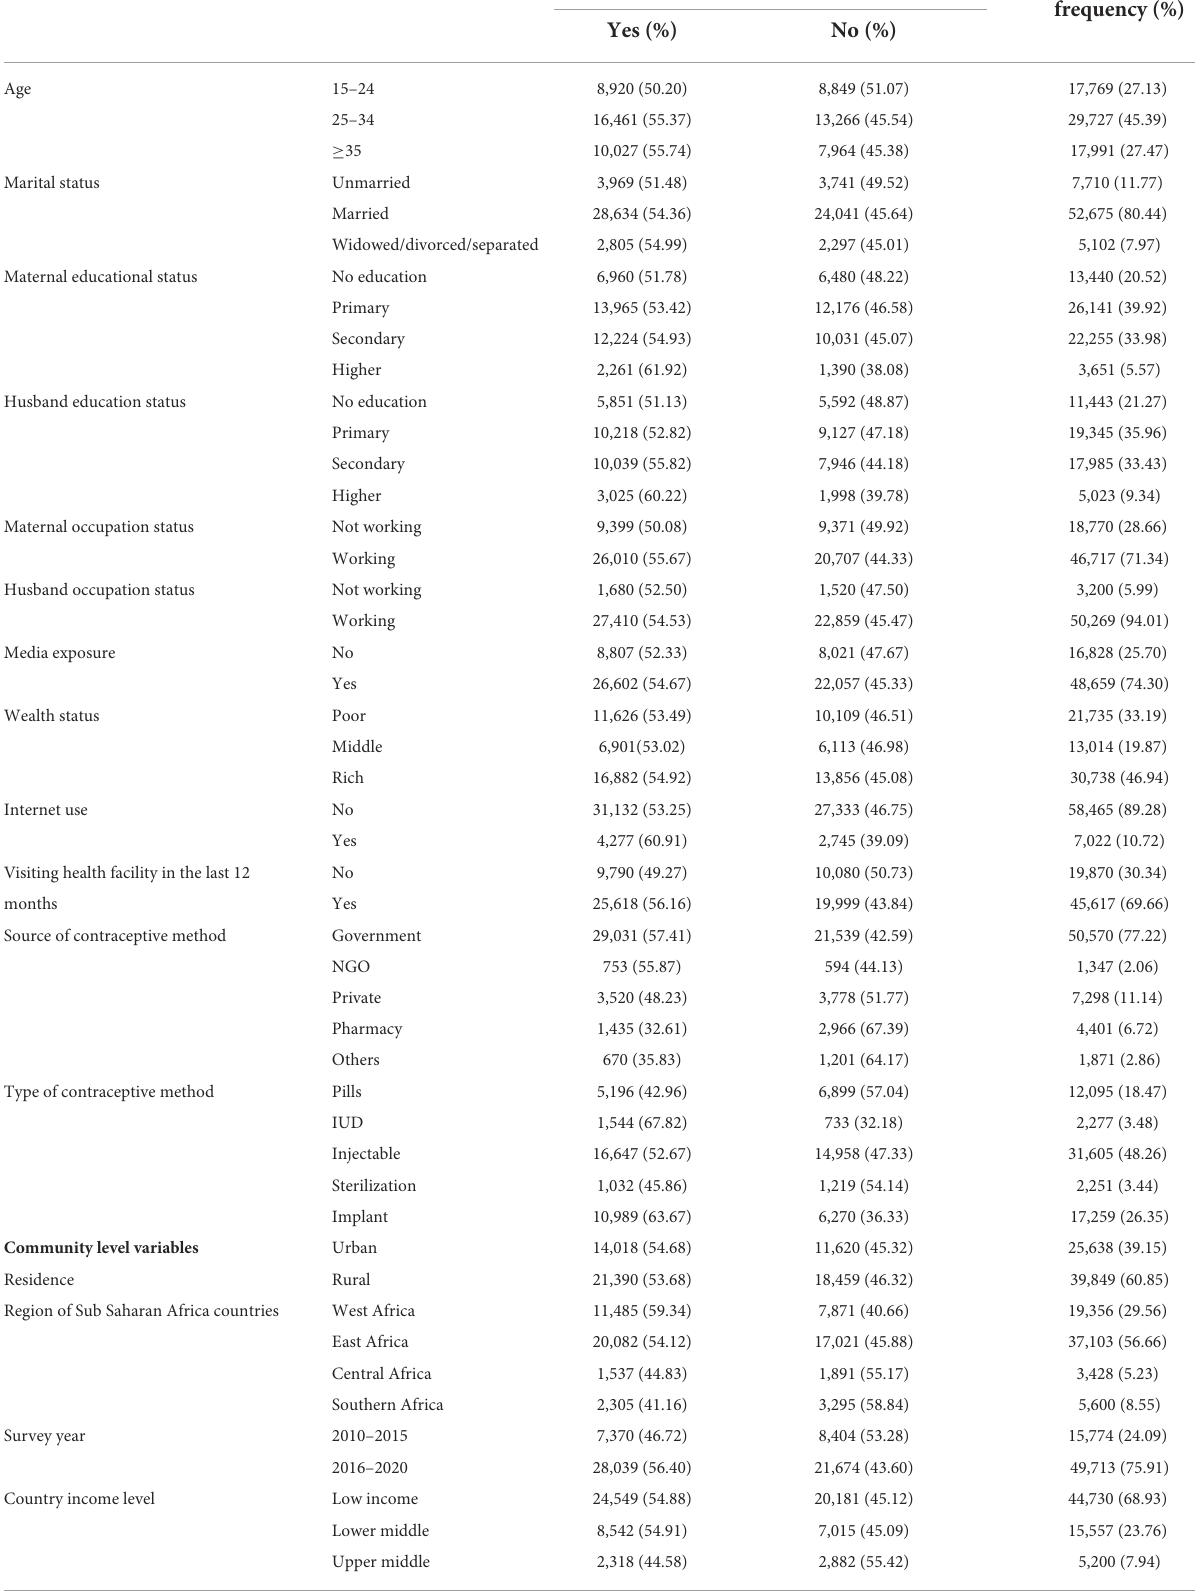
TABLE 2 Descriptive characteristics of the study participants in Sub-Saharan Africa.